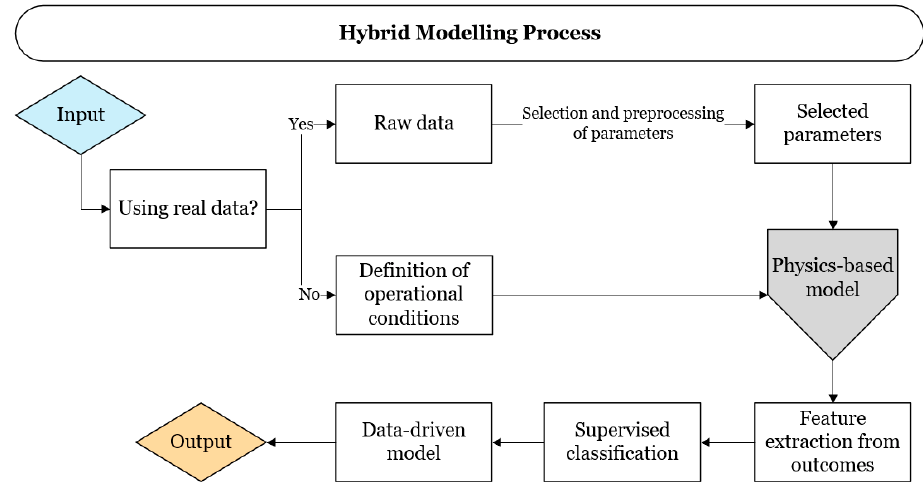
Figure 3. Methodology used for building the hybrid model (HyM).